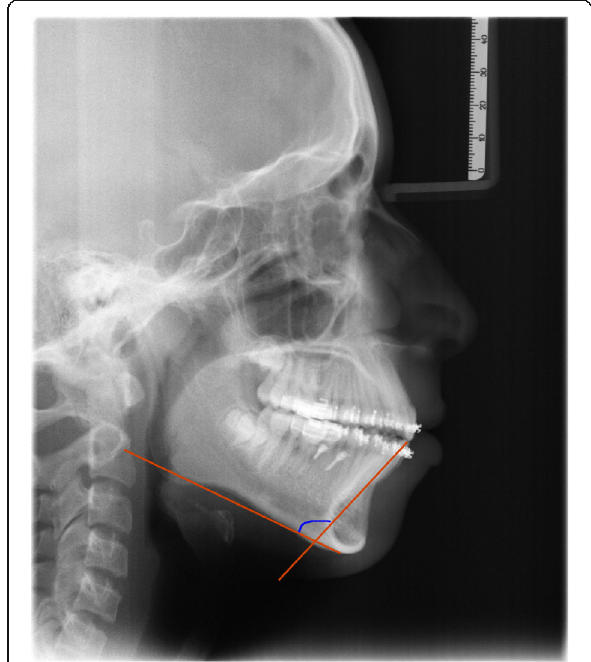
Fig. 3 L1 mandibular plane angle, the primary outcome of the study